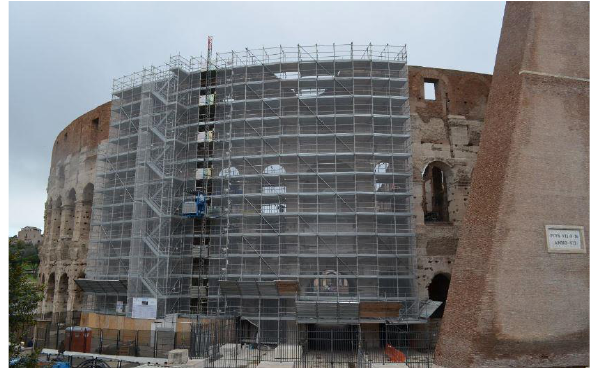
Figure 12. Construction site for the study of the columns affected by the current